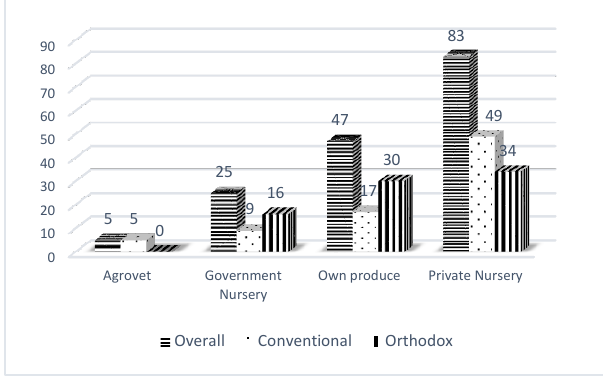
Figure 3: Major source of planting